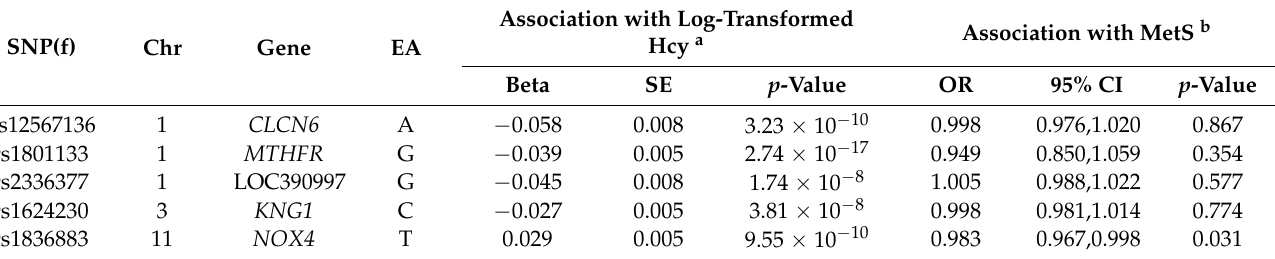
Table 3. Effect estimates for associations of genetic instruments with Hcy and MetS.